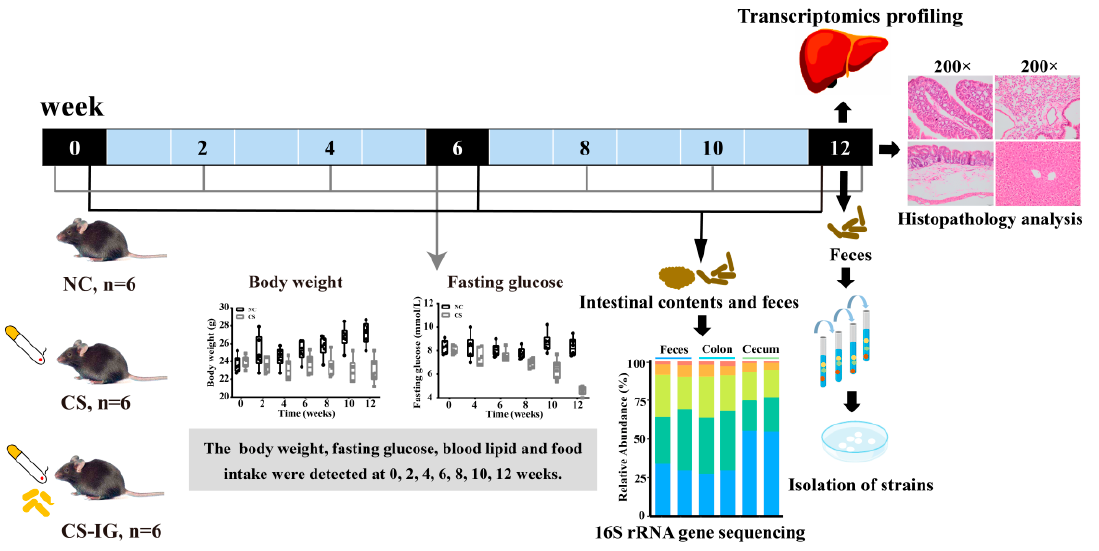
Figure 1. Schematic representation of the experimental design. Mice were treated with normal air exposure (NC group, n = 6) or cigarette smoke exposure (CS group, n = 6). In addition, mice were intragastrically administered normal saline without bacteria (NC and CS group, n = 6) or with strain JQ581 (CS-IG group, n = 6). After two weeks of environmental adaptation, mice with similar body weights and blood sugar and lipid indices were selected and grouped randomly to ensure that the state of the mice before the experiment was consistent. The mice in the CS and CS-IG groups were exposed to 2 cigarettes at an air flow rate of 3L/min for 20–30 min at a time and exposed three times a day. The treatment lasted for 12 weeks.